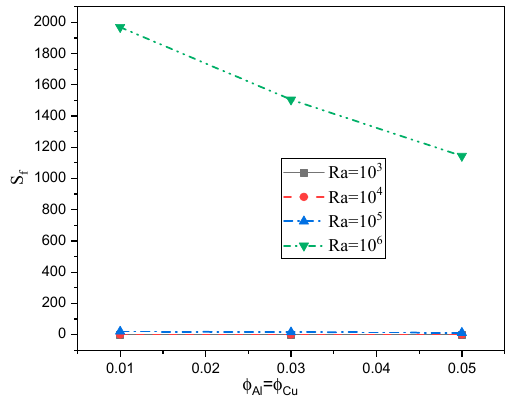
Figure 13. Profiles of the S f in the entire domain for the variation of the Rayleigh number and nanoparticle volume fraction φ Al = φ Cu at Ha = 15, H = 0.1, γ = π /6, Φ = π